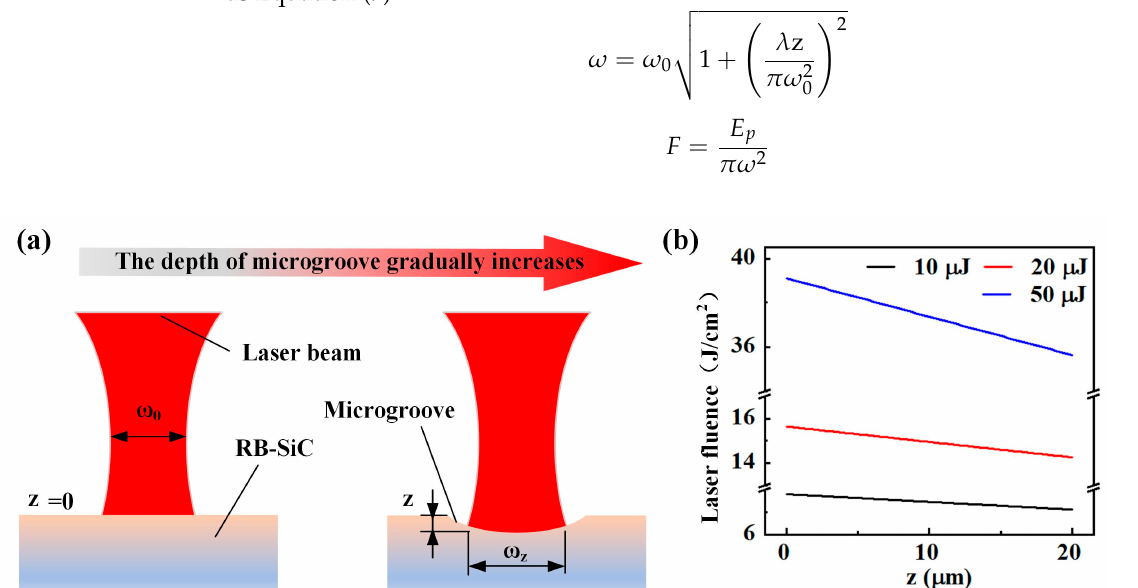
Figure 14. E ff ect of microgroove depth on the laser fl uence. ( a ) Schematic diagram of the depth Figure 14. Effect of microgroove depth on the laser fluence. ( a ) Schematic diagram of the depth varia- variation of the microgroove cross-section. ( b ) Variation in laser fl uence with the depth of micro- tion of the microgroove cross-section. ( b ) Variation in laser fluence with the depth of microgroove. groove. Here, ω 0 is the waist radius of the femtosecond laser beam, and z represents the depth of the ablation microgroove. After the first pass produced a microgroove, the laser was in a positive defocus state because the focal point did not move. As the depth increased with subsequent passes, the laser fluence at the defocused position gradually decreased, and the drop could reach 10% at a maximum depth of 20 µ m (Figure 14b). Therefore, the first reason was that the laser fluence decreased due to the increased defocus,